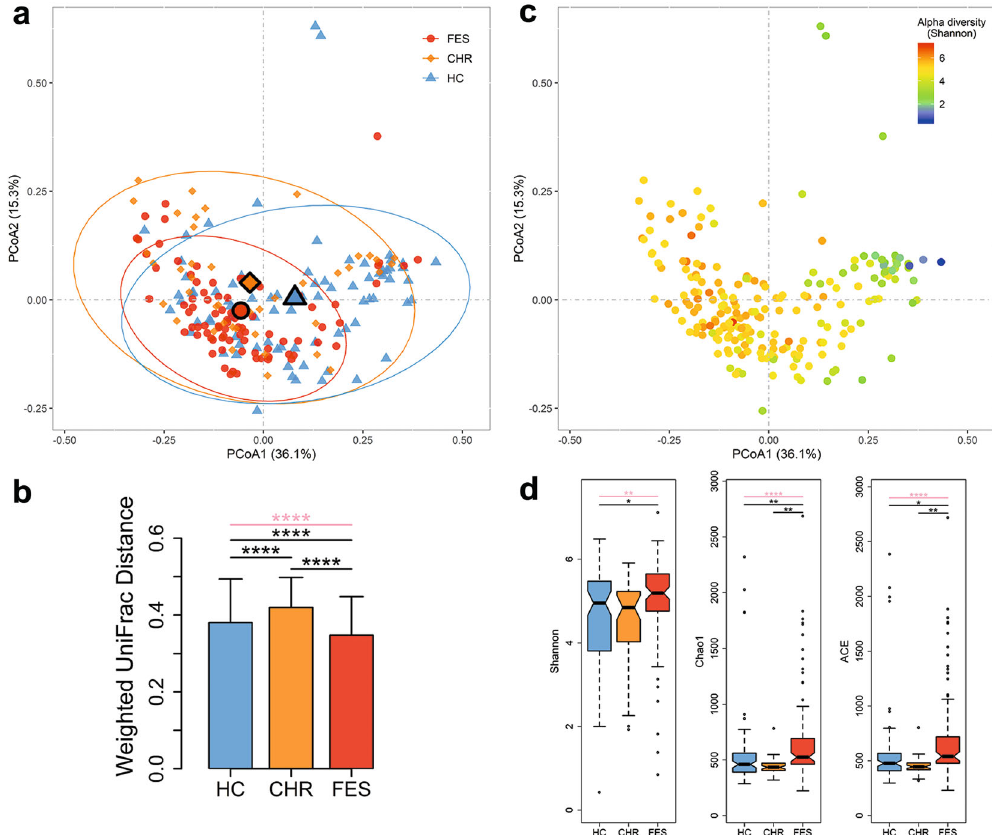
Fig. 1 The overall salivary microbiome composition differs according to different clinical stages of schizophrenia (FES, CHR and HC) in 208 subjects. The principal coordinate analysis was conducted based on the weighted UniFrac distances, with 95% con fi dence ellipses drawn and centroids representing the coordinate mean of the fi rst and second axes. Each sample is colored either by the disease phenotype ( a ) or the Shannon diversity index ( c ). b Comparison of within-group distances among the three groups. The bar plots show median values for each group and error bars show interquartile range. d Comparison of three α -diversity indices among the three groups. Center lines of box plots show median values, box hinges indicate fi rst and third quartiles, and whisker represent the furthest data points within 1.5 interquartile ranges of the hinges. The comparisons among the three groups were performed by the Kruskal – Wallis test and the comparisons between the two groups were conducted by the quantile regression, adjusting for age, gender, and education level. * p < 0.05; ** p < 0.01; *** p < 0.001; **** p < 0.0001. Pink lines represent comparisons among the three